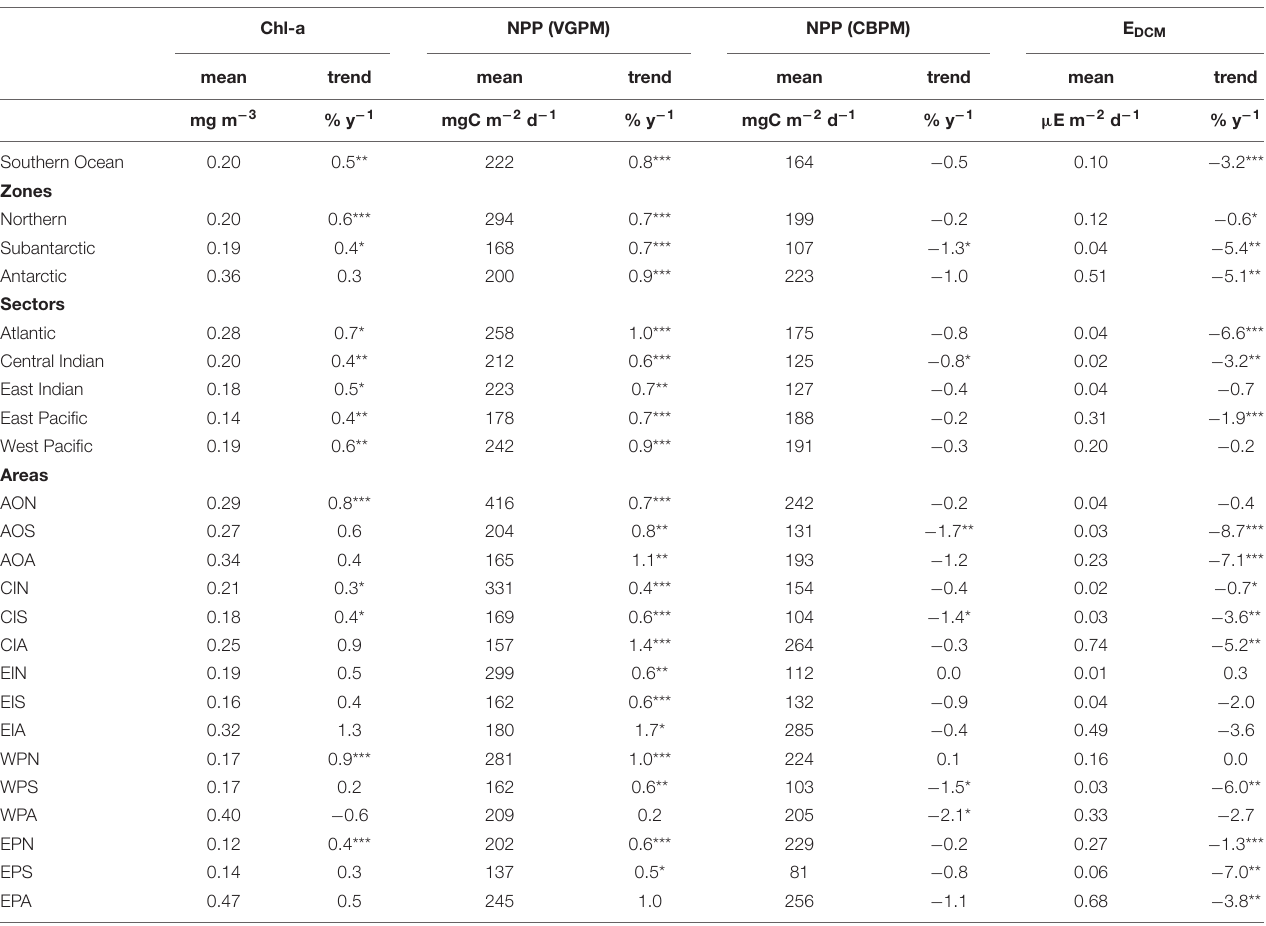
TABLE 3 | Annual average mean values and long-term linear trends (1997–2019) for: phytoplankton biomass (chl-a concentration); net primary production (NPP) by the vertically-generalised production model (VGPM) and carbon-based production model (CBPM); and irradiance at the base of the mixed-layer (E DCM ) proxy of primary production in the deep chlorophyll maximum